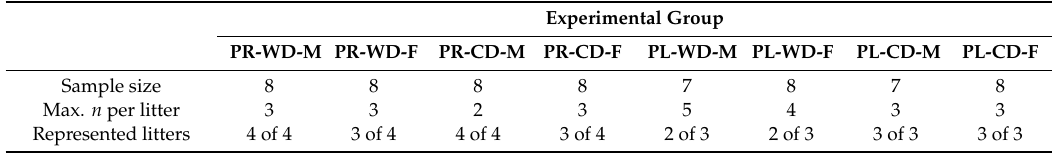
Table 1. Litter diversity details for each of the eight experimental groups including total sample size, maximum subjects per litter in each group, and represented litters of total by treatment (four probiotic, three placebo). PL: placebo; PR: probiotic; WD: Western diet; CD: control diet; M: male; F: female. Experimental